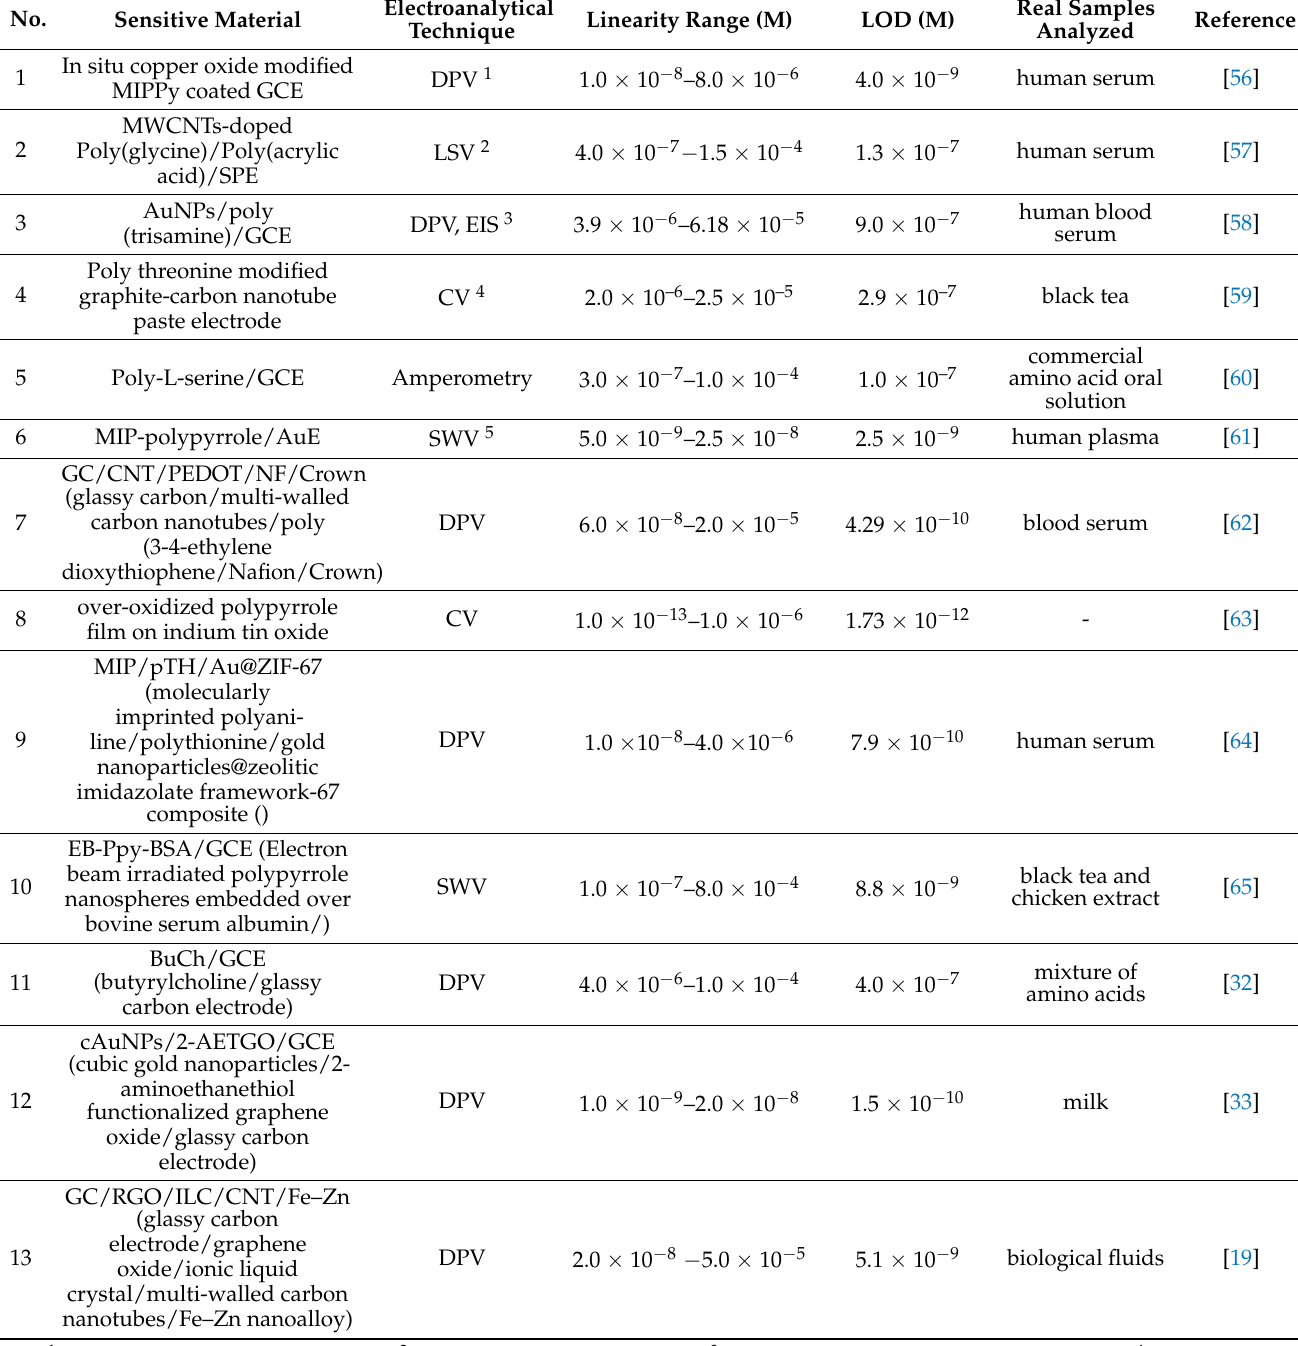
Table 6. Performance characteristics of several electrochemical sensors in the detection of